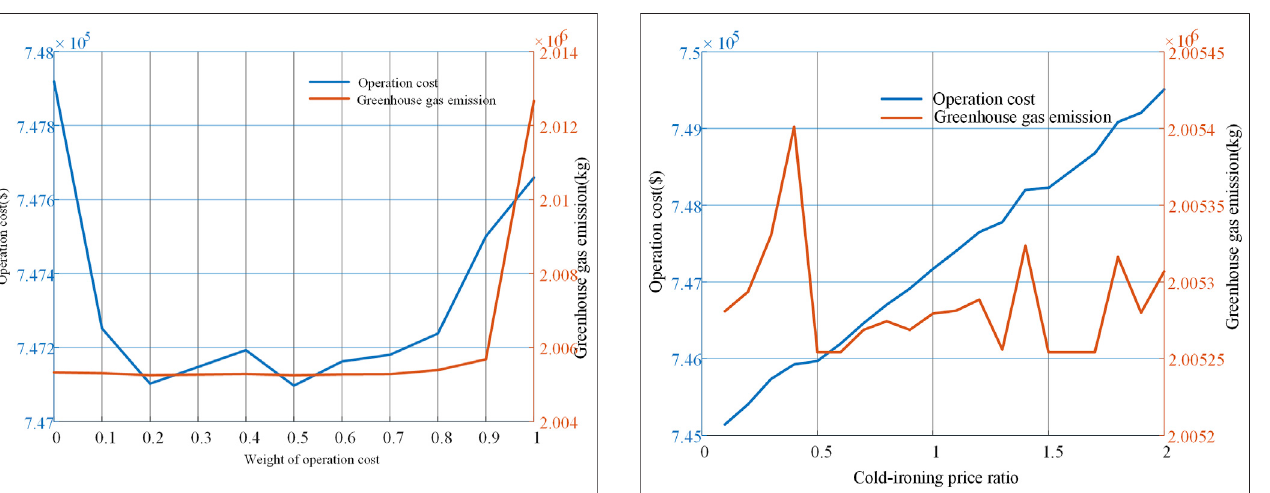
FIGURE 11 | Sensitivity analysis of cold-ironing price